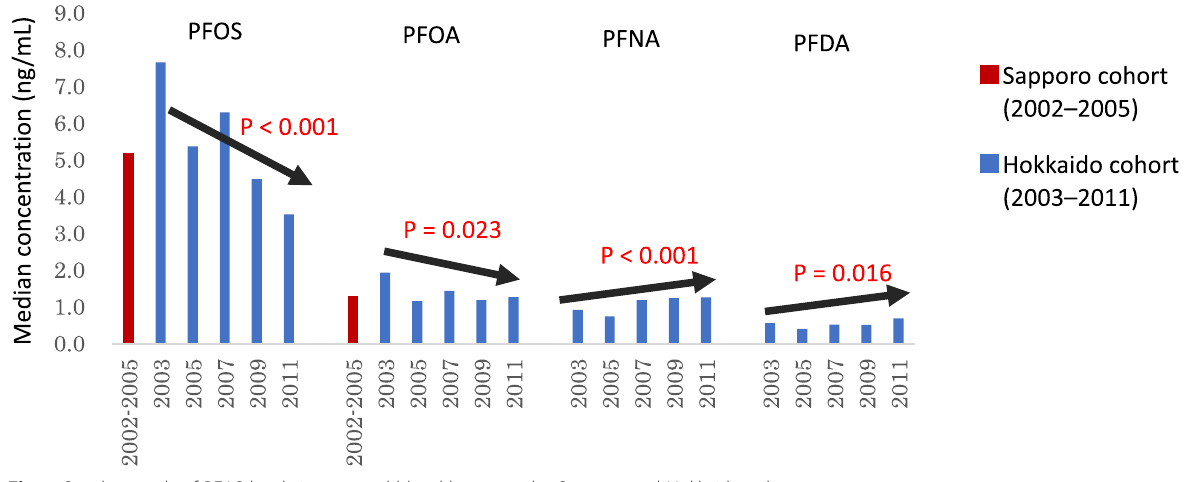
Fig. 4 Secular trends of PFAS levels in maternal blood between the Sapporo and Hokkaido